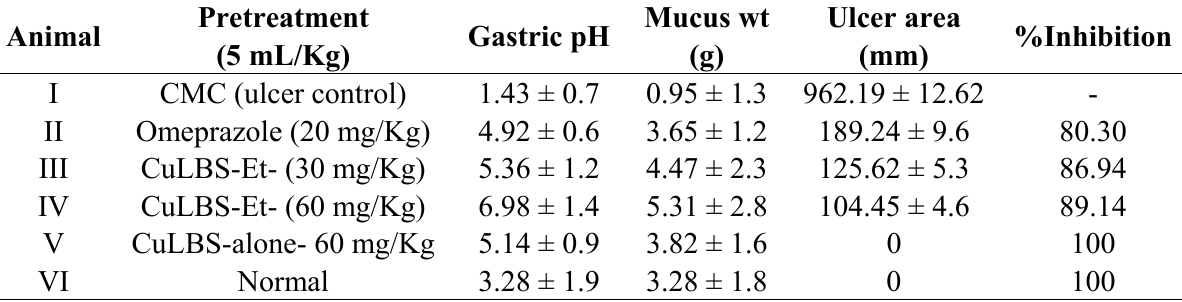
Table 5. Observed ulcer area and %Inhibition.